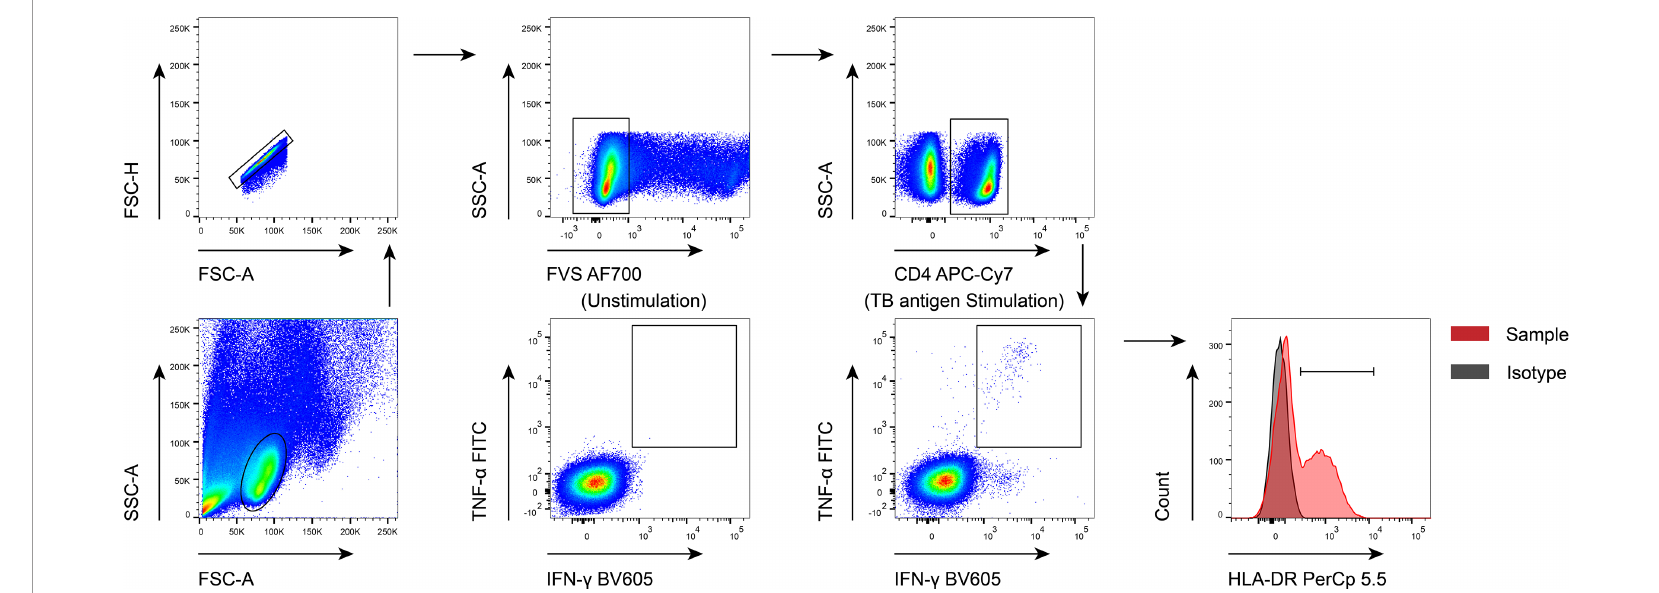
FIGURE 1 | The gating strategies used in the current study. FVS, fl exible viability stain; TB,